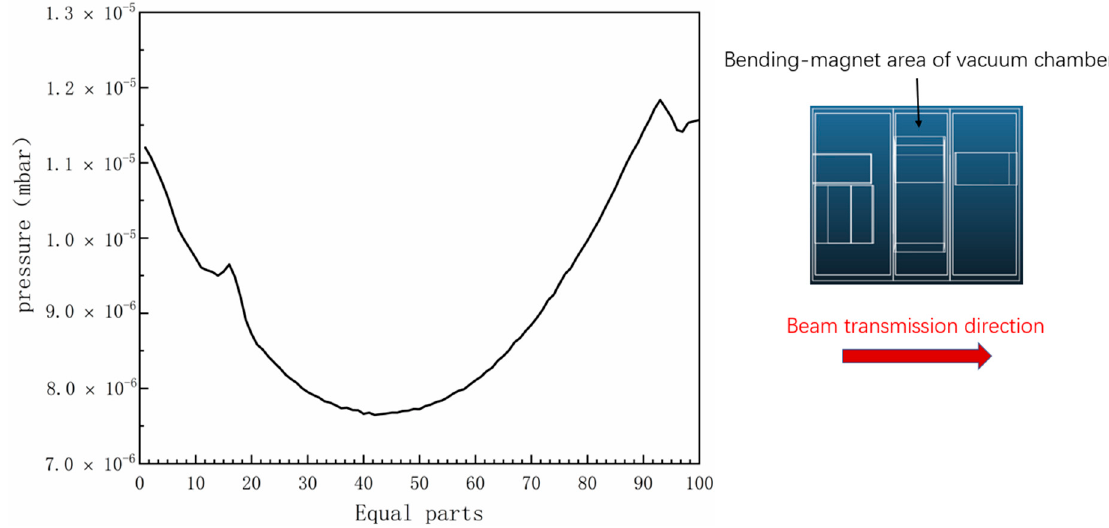
Figure 10. Pressure distribution in the bending-magnet area after the vacuum chamber is dynamically balanced.